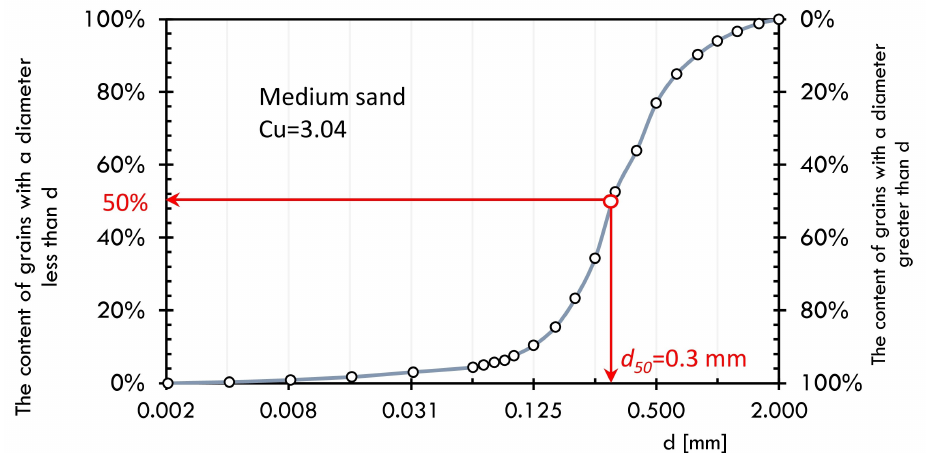
Figure 4. Grains distribution of sand (Cu—homogeneity index based on